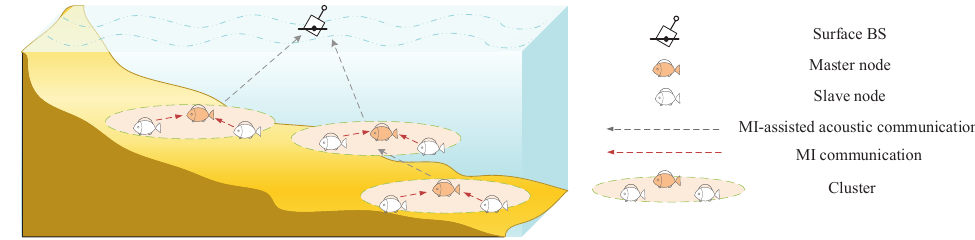
Figure 1. The system architecture of underwater MI-assisted acoustic cooperative MIMO